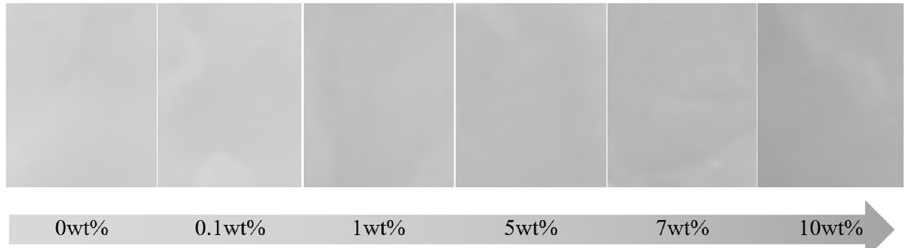
Figure 5. Optical images of PAN/bio-based PU/Ti 3 C 2 T x MXene composite membrane with different MXene